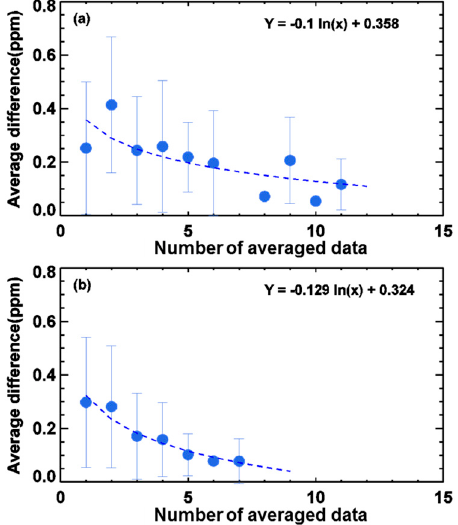
Figure 5. Error induced by spatio-temporal sampling error over: ( a ) Tsukuba; and ( b ) Saga TCCON sites, with the standard deviation given by error bars. The dashed line represents the logarithmic least square fit curve.